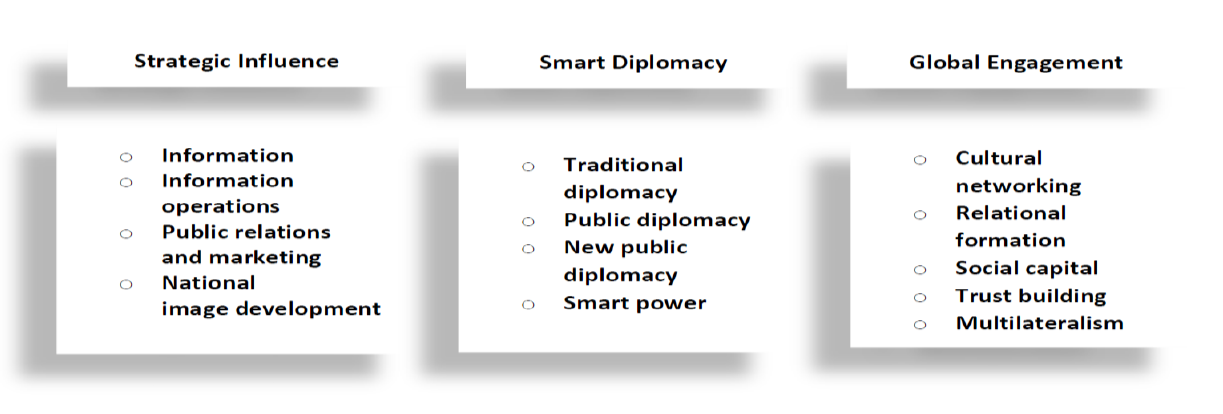
Figure 2 . Model of strategic influence and global